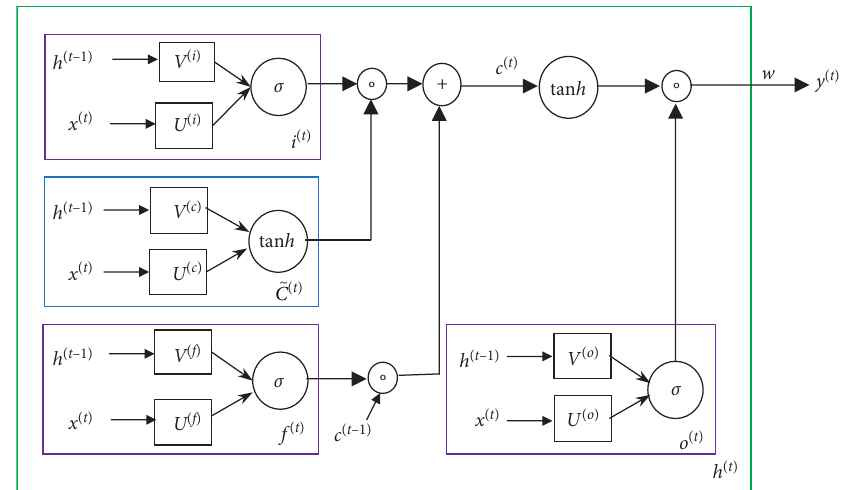
Figure 3: Structure diagram of a LSTM node.